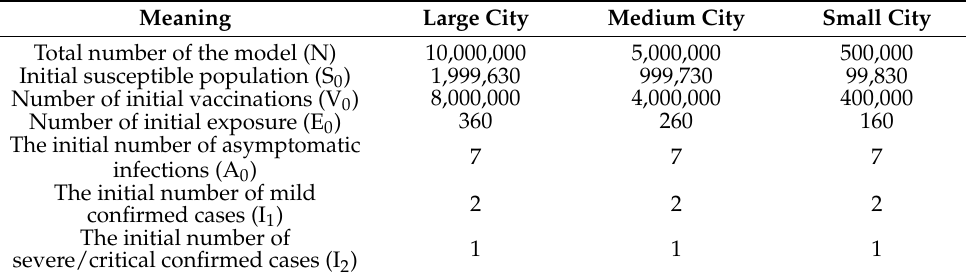
Table 2. Initial values of scenario simulation for cities of different sizes. Meaning Large City Medium City Small City Total number of the model (N) 10,000,000 5,000,000 500,000 Initial susceptible population (S 0 ) 1,999,630 999,730 99,830 Number of initial vaccinations (V 0 ) 8,000,000 4,000,000 400,000 Number of initial exposure (E 0 ) 360 260 160 The initial number of asymptomatic 7 7 7 infections (A 0 )